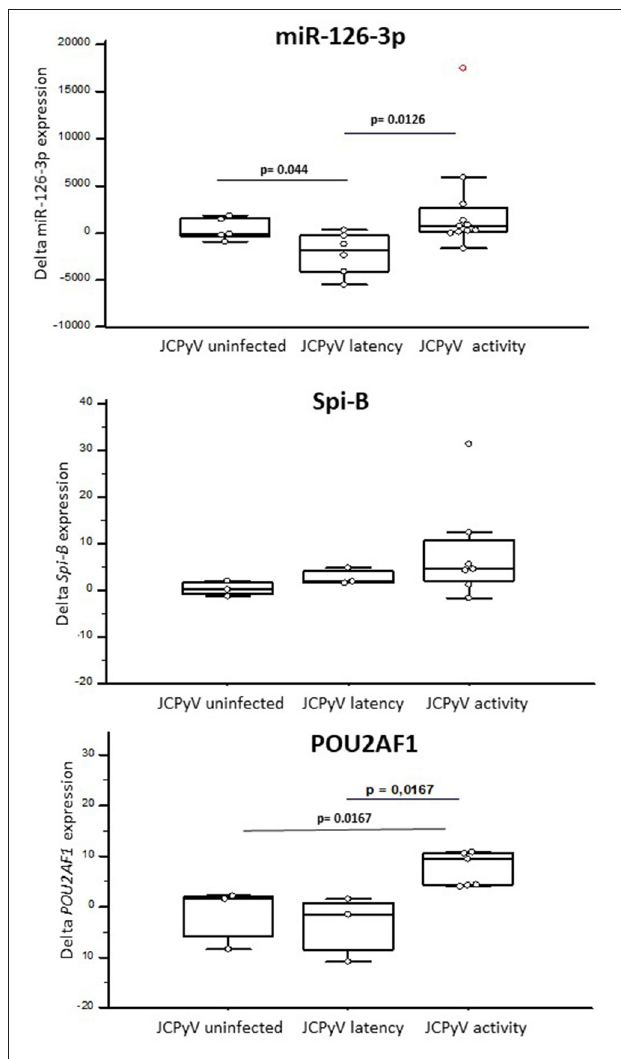
FIGURE 4 | The expression of miR-126-3p (A) , POU2AF1 (B) , and Spi-B (C) in RRMS patients treated with NTZ, clusterized based on the lack of JCPyV infection (JCPyV uninfected) ( N = 3) or on its presence in a latent (latency) ( N = 3) or replicating (activity) ( N = 7) form. Increases or decreases (delta) compared with baseline after NTZ therapy are shown as box and whiskers plot, where the box indicates the median and the first and third quartiles; the whiskers extend from the lowest to the highest values of the dataset. Statistical significance (Mann–Whitney test) is